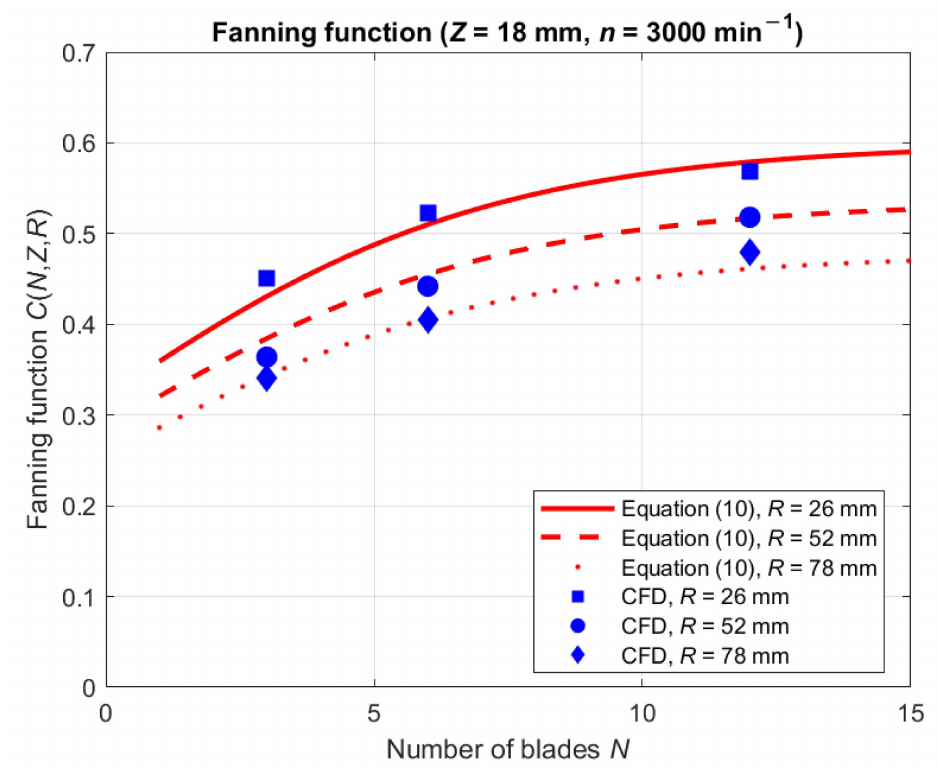
Figure 13. Fanning function C ( N , Z , R ) vs. the number of blades N ( Z = 18 mm) at n = 3000 min − 1